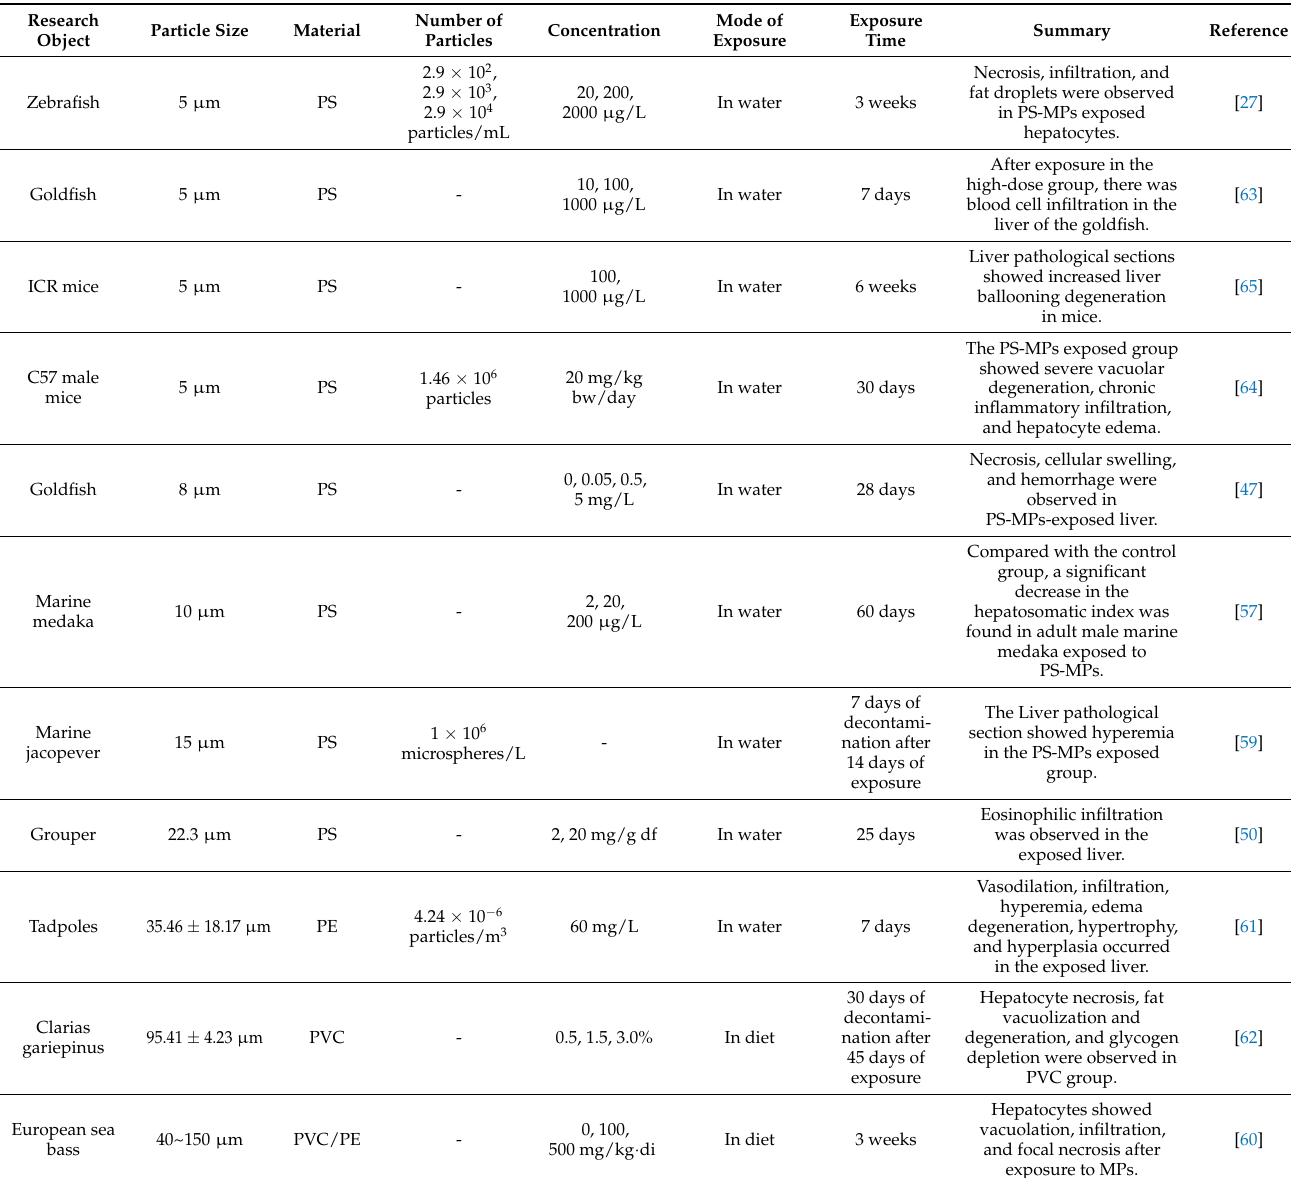
Table 4. The study parameters and effects of hepatic pathomorphological changes caused by MPs on the